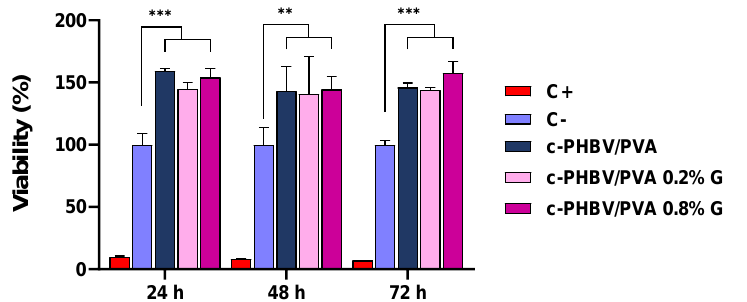
Figure 10. Cell viability after 24, 48, and 72 days from MTS assay. Semi-IPN c-PHBV/PVA and nanohydrogels with 0.2% and 0.8% of graphene nanosheets. Positive control: growth medium with latex extract as cytotoxic agent. Negative control: growth medium. Graph shows mean ± standard deviation; (**) and (***) indicate significant differences ( p < 0.01 and p < 0.001, respectively). growth medium and without any materials, considered as 100% viability) in the